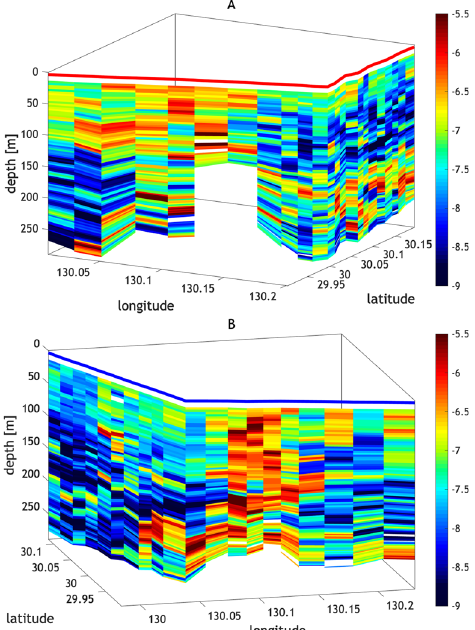
Fig. 8 Measured turbulent kinetic energy dissipation rates during November 2019 cruise. Measured dissipation rates (log 10 W kg − 1 ) for ( a ) leg 1 along the red line in Fig. 7 and for ( b ) leg 2 along the blue line in Fig. 7.